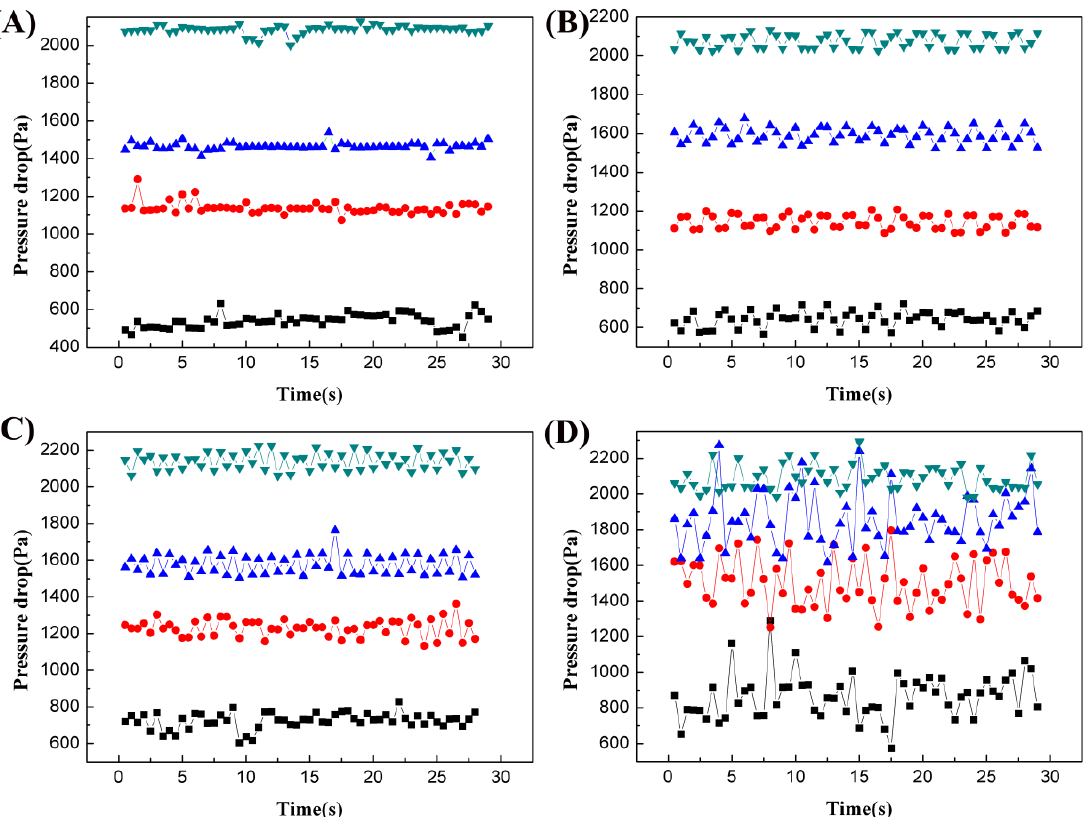
Figure 5. The time evolution of the pressure drop at different bed heights and superficial velocities when the particle size is 1.25 ± 0.25 mm and particle density is 1500 kg/m 3 : ( A ) ν s = 0.0167 m/s; ( B ) ν s = 0.0208 m/s; ( C ) ν s = 0.025 m/s; ( D ) ν s = 0.0292 m/s.